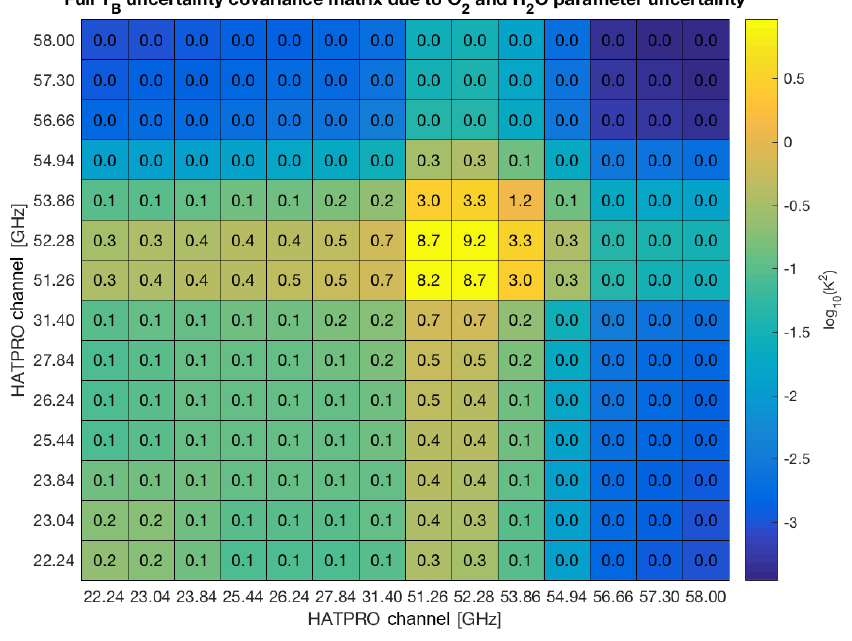
Figure 9. T B uncertainty covariance matrix due to O 2 and H 2 O absorption model parameter uncertainty at HATPRO channels for US standard climatology. Numbers in the table are in K 2 , while the color scale is in log 10 (K 2